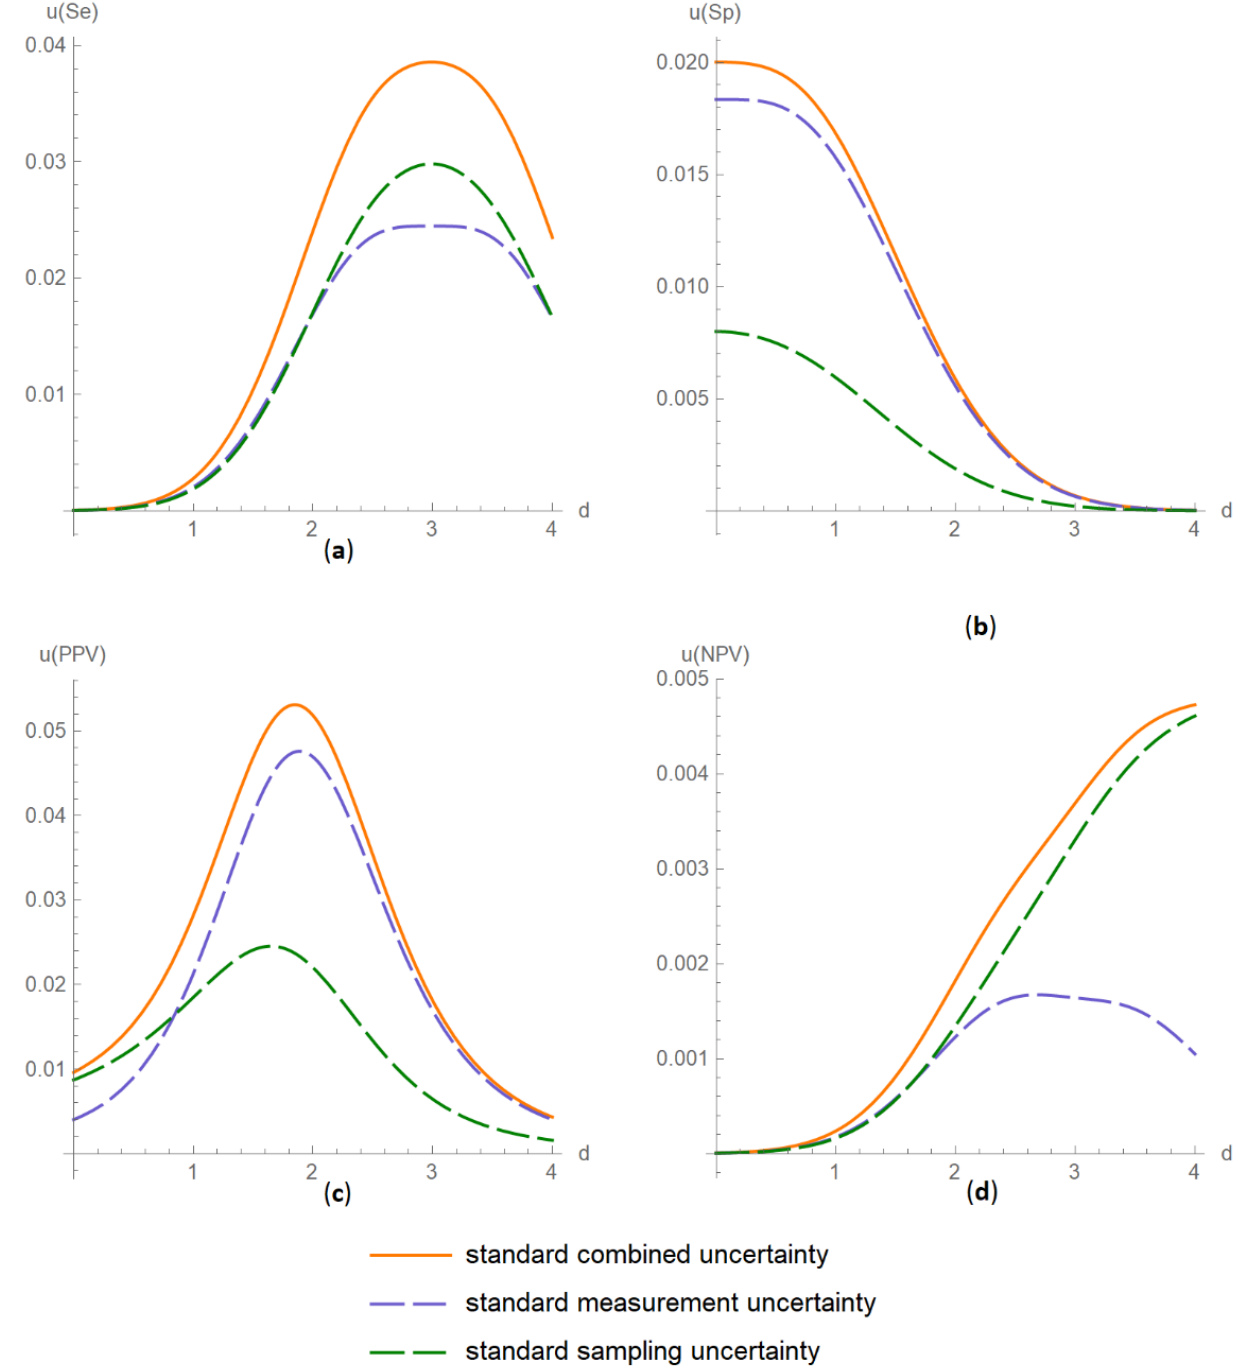
Figure 15. Histogram of standard combined, measurement and sampling uncertainties of diagnostic accuracy measures, Figure 15. DAM standard uncertainties versus diagnostic threshold plots. Plots of standard combined, measurement and with the respective parameter settings in Table sampling uncertainties of ( a ) sensitivity (u( Se )), ( b ) specificity ( u ( Sp )), ( c ) positive predictive value ( u ( PPV )) and ( d ) nega- tive predictive value ( u ( NPV )) versus diagnostic threshold ( d ) curves, with the respective parameter settings in Table 4.